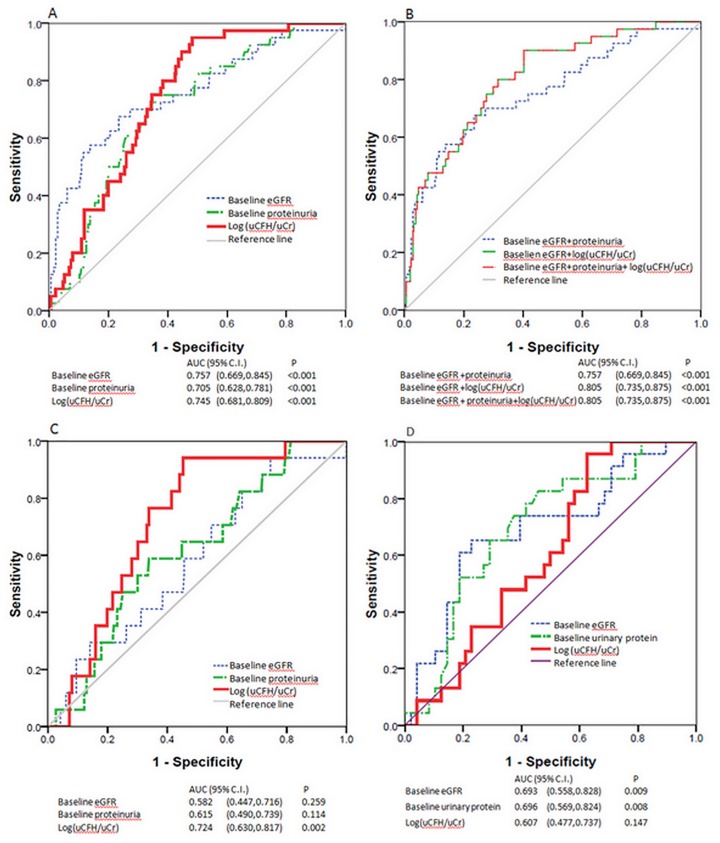
ROC curve analysis of the predictive value for adverse outcomes of eGFR, proteinuria, log(uCFH/uCr) and their combination.ROC: receiver operating characteristic curve; AUC: area under curve. A. ROC for renal outcome in the whole cohort. B. Incorporated ROC for renal outcome in the whole cohort. C. ROC for renal outcome in a subgroup with eGFR≥60mL/min/1.73m2. D. ROC for renal outcome in a subgroup with eGFR<60mL/min/1.73m2.